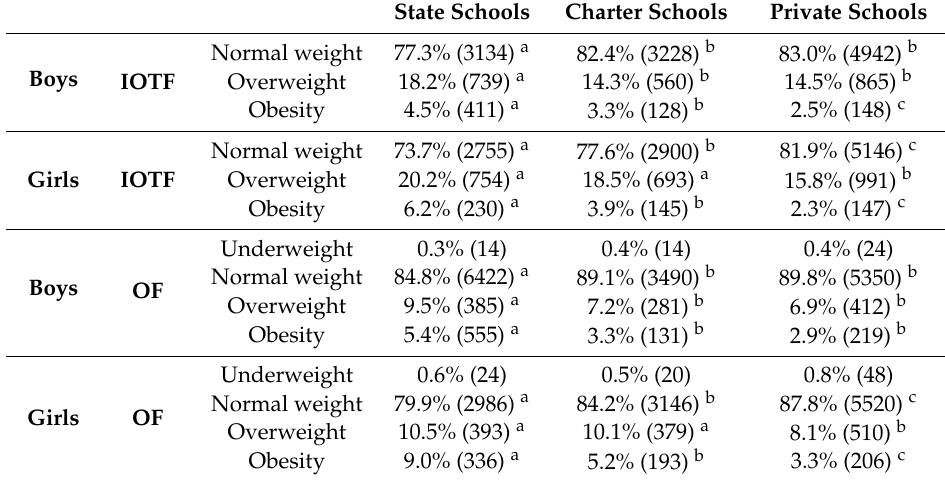
Table 5. Global prevalence of underweight, normal weight, overweight and obesity by school type and sex in the 2010–2019